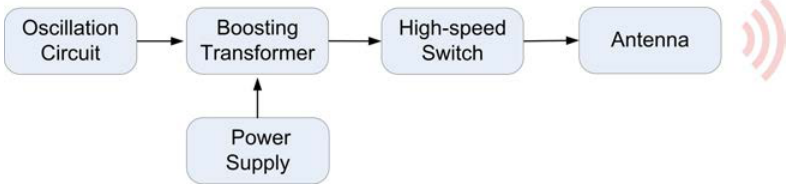
Fig. 3. Schematic diagram of high-voltage discharged mode.